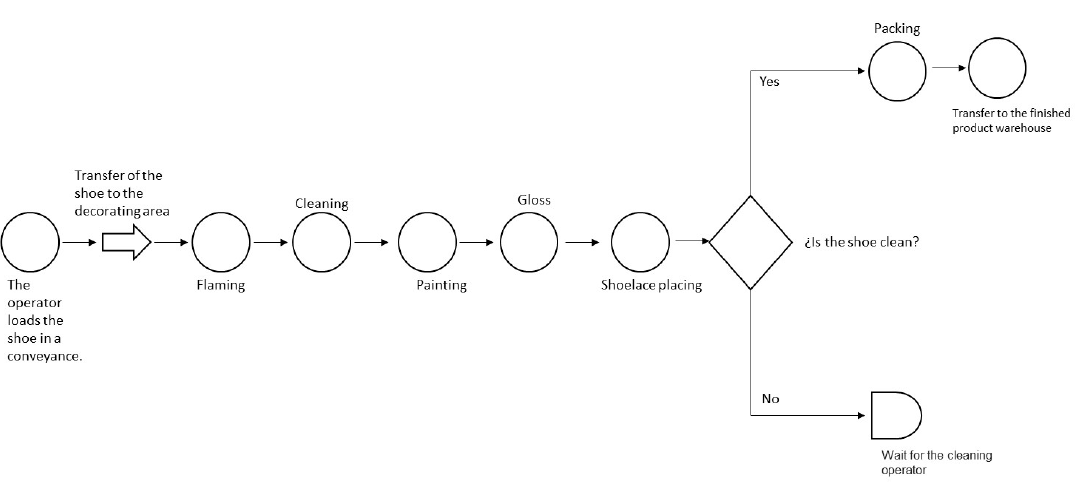
Figure 5. Process flow diagram elaborated by the author.